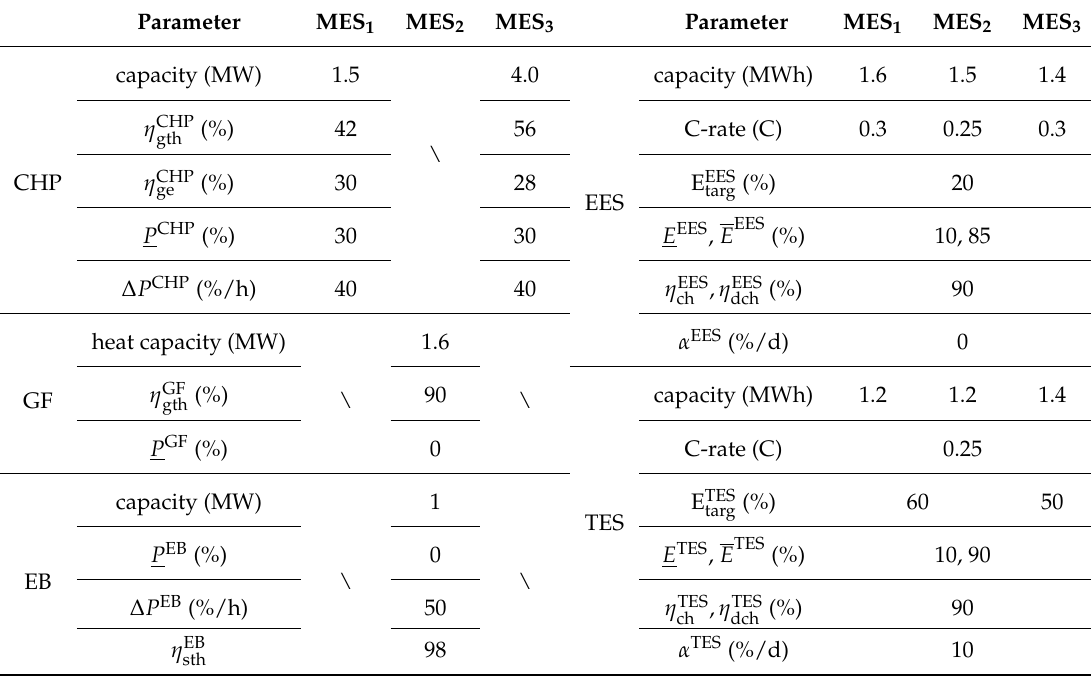
Table 2. Parameters of